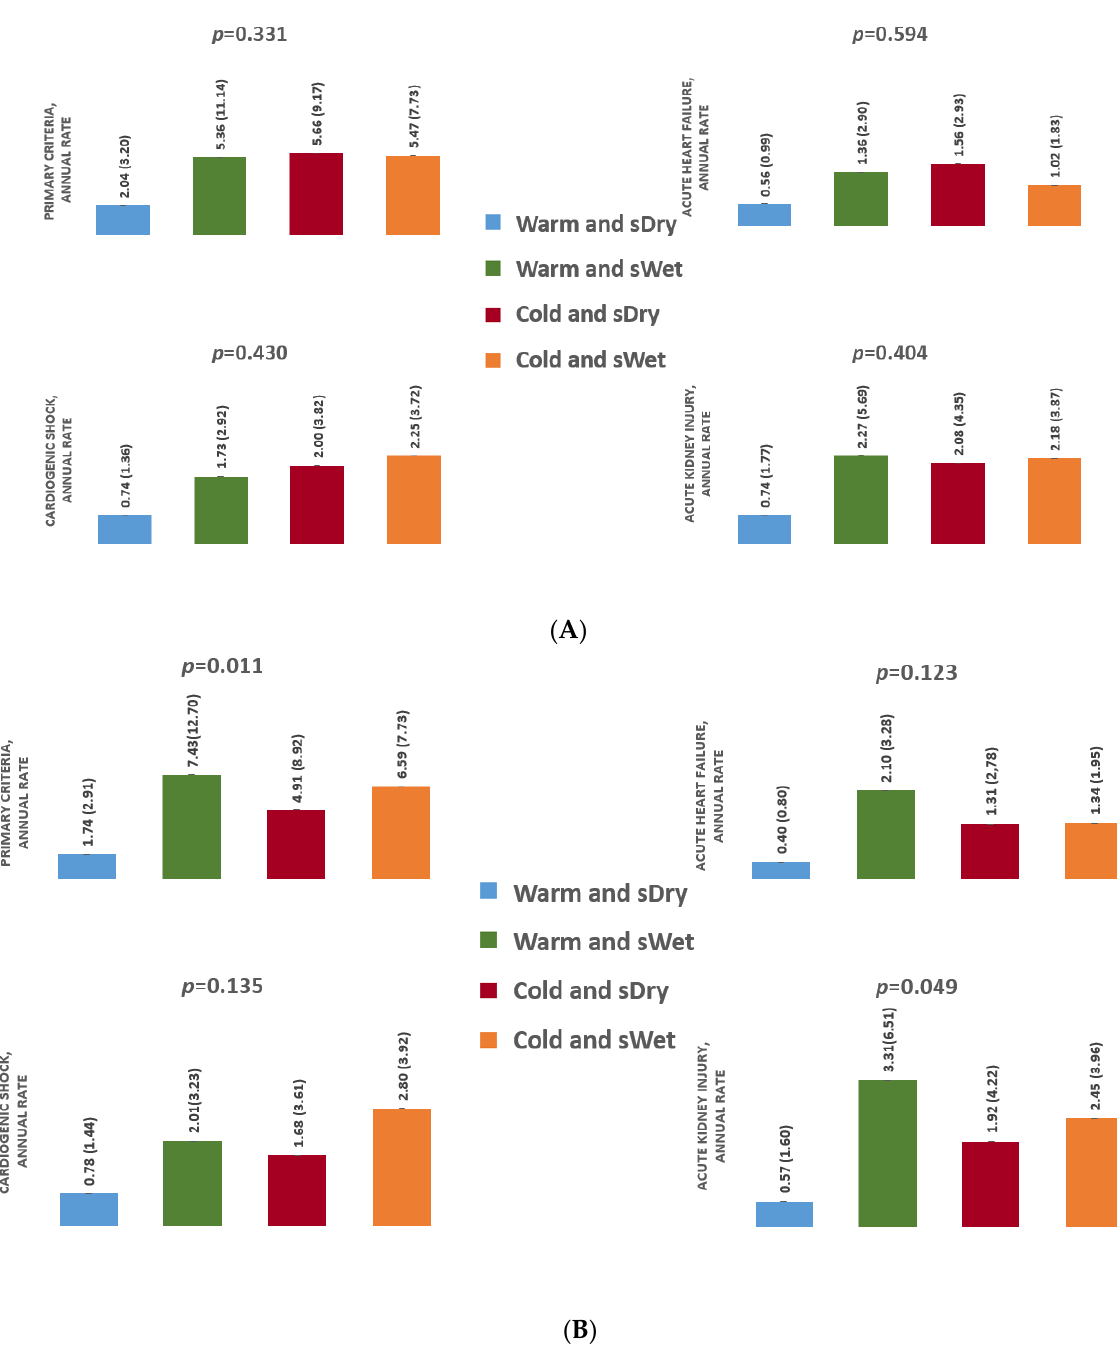
Figure 1. Event rate by group according to PCWP ( A ) and CVP ( B ), expressed in events/patient*year. CVP, central veinous pressure; PCWP, pulmonary capillary wedge pressure.